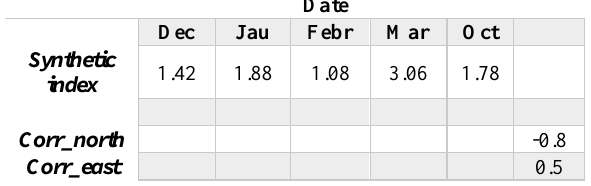
Figure 5. Correlation plot between camera calibration paramaters and principal components extracted by processing the dataset acquired in Juanuary. F: focal length; Cx and Cy coordinates of the principal point offset; B 1 , B 2: Skew Figure 8. Correlation plot between camera calibration parameters; k1, k2, k3, k4: radial distortions; p1, p2, p3, p4: paramaters and principal components extracted by processing components of the decentring distortions; Dim.1-Dim.13: the dataset acquired in October. F: focal length; Cx and Cy principal components. coordinates of the principal point offset; B 1 , B 2: Skew parameters; k1, k2, k3, k4: radial distortions; p1, p2, p3, p4: components of the decentring distortions; Dim.1-Dim.13: principal components. Table 1 - Synthetic computed index. Dec: December, Jua: January, Feb: February; Mar: March, Oct: October; Corr_north: correlation between the synthetic index and the northern error component; Corr_east: correlation between the synthetic index and the eastern error component.